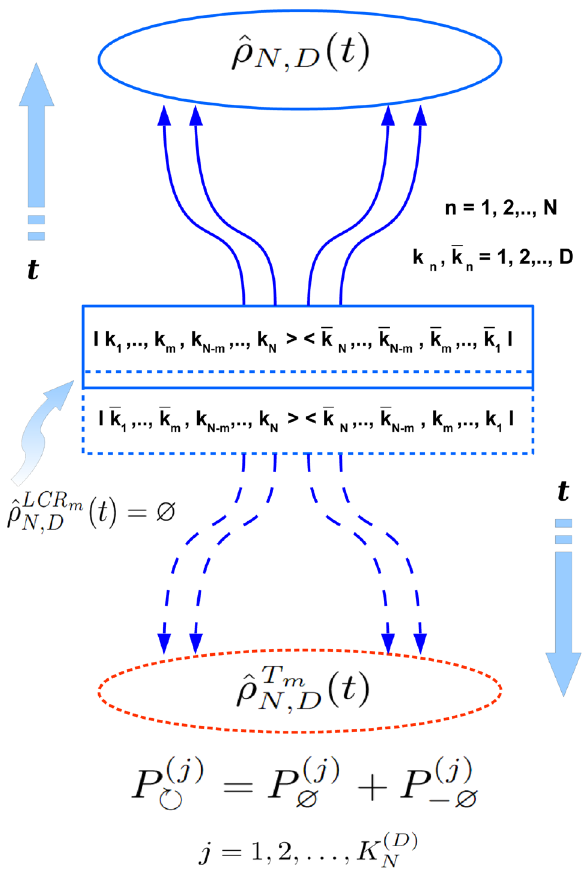
N Hilbert space (encoding N 1, 2, . . . N 1 ). = −